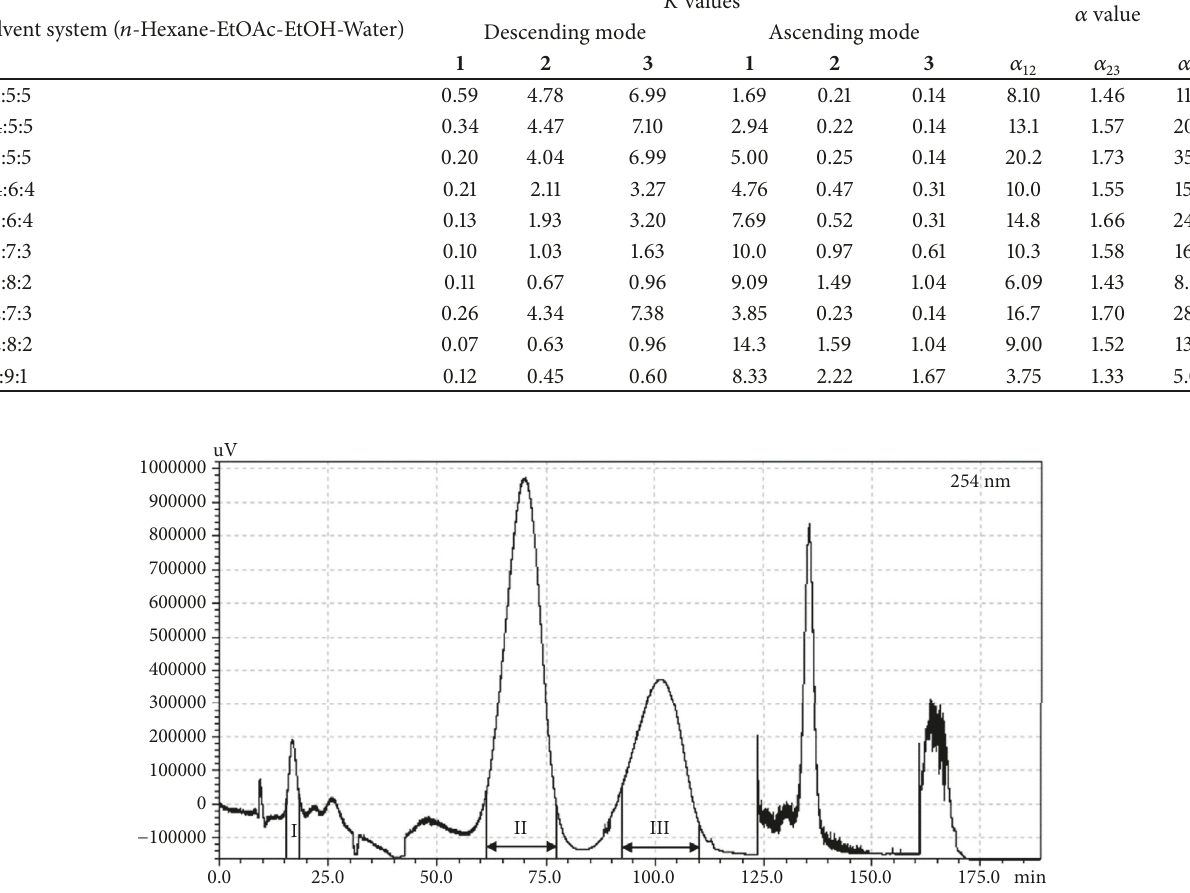
their measured K and 𝛼 values are summarized in Table